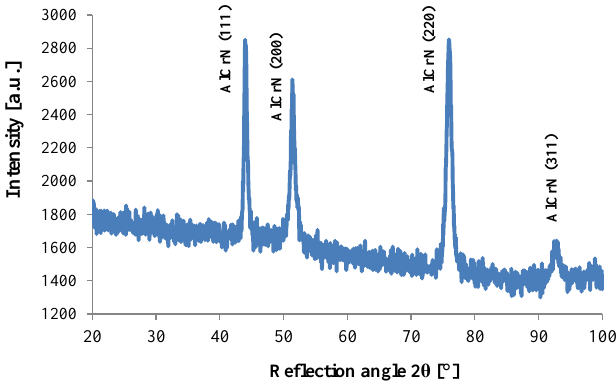
Figure 2. GIXRD spectra of the AlCrN + CrCN coating.